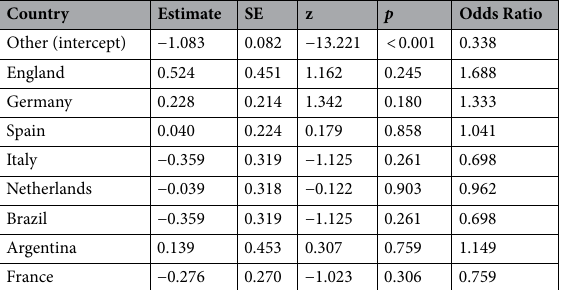
Table 4. Coefficients for the different nationalities in the binomial regression model for all in-game penalty kicks faced by goalkeepers during Champions League and Europa League matches (341 of 1,358 penalty kicks were missed against 512 different goalkeepers in the analyzed time periods).